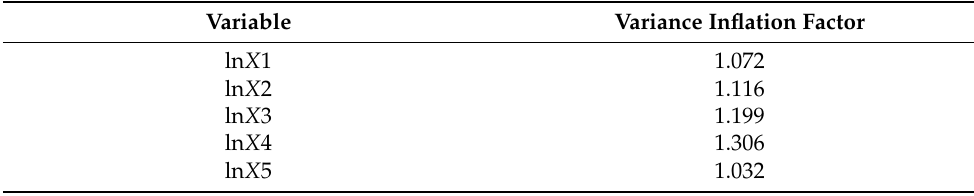
Table 6. Multicollinearity statistics based on variance inflation factor